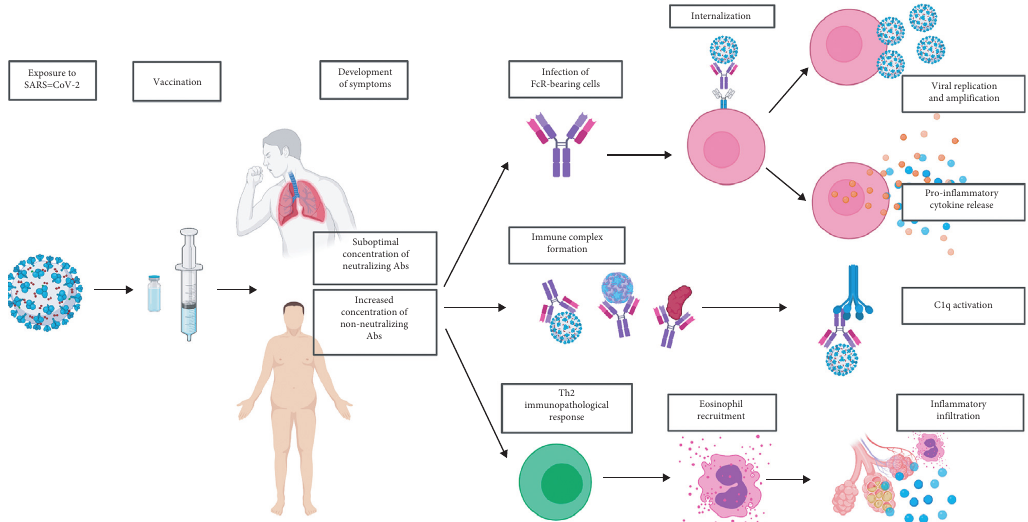
Figure 4: In VADE, the exposure to SARS-CoV-2 leads to asymptomatic infection, which is subsequently followed by vaccination and the development of symptoms. Patients then develop a suboptimal level of neutralizing antibody or increased level of nonneutralizing antibody or both. These lead to the development of VADE or ERD, in which immune response and inflammation are enhanced by the vaccine in previously infected individuals through the abovementioned mechanisms. Abs,